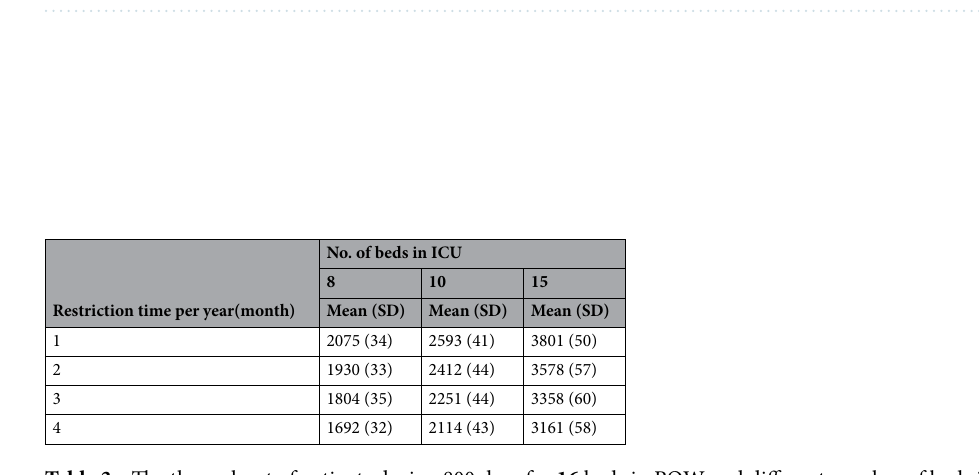
Figure 5. Length of Stay (LOS) in ICU after operation for different number of beds in ICU and post operative ward (POW).